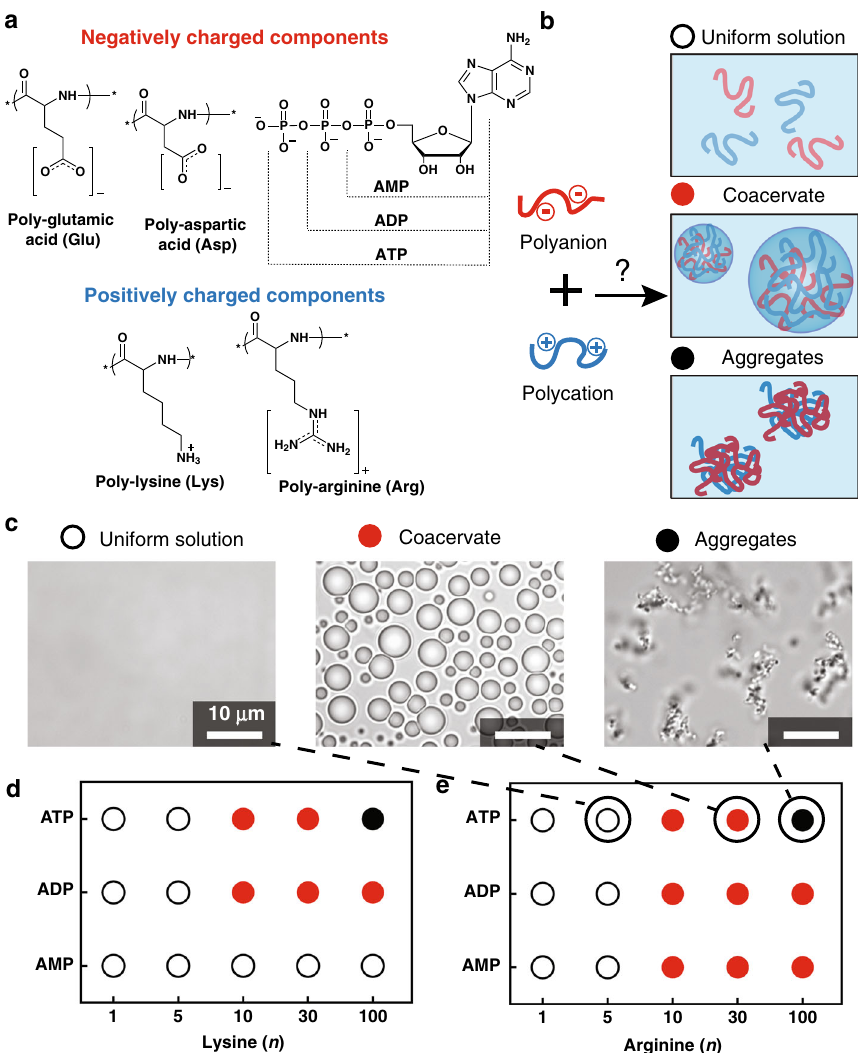
Fig. 1 A complex coacervate library comprising pairs of oppositely charged peptides and nucleotides. a Structures of negatively and positively charged molecules used as polyanions and polycations in evaluation of coacervation (the nucleotide terminal phosphates are dianionic at pH 8.0 with pKa ≈ 1 and ≈ 6. 8). b Combination of positively and negatively charged components led to a uniformly mixed solution, coacervation, or aggregation, depending on the details. c Optical microscope images illustrating samples categorized as uniform solution (white circles), coacervates (red circles) and aggregates (black circles); these particular samples are ATP with (Arg) n ( n = 5, 30, and 100, left-to-right), corresponding to the points highlighted in panel e . Summary of fi ndings for d (Lys) x - and y -axes go in the direction of increasing charge. Images are obtained over 1 – 100 and e (Arg) 1 – 100 with AMP, ADP, and ATP. The analysis of at least three independent trials and phase diagrams are result of these observations along with turbidity measurements. All scale bars represent 10 μ